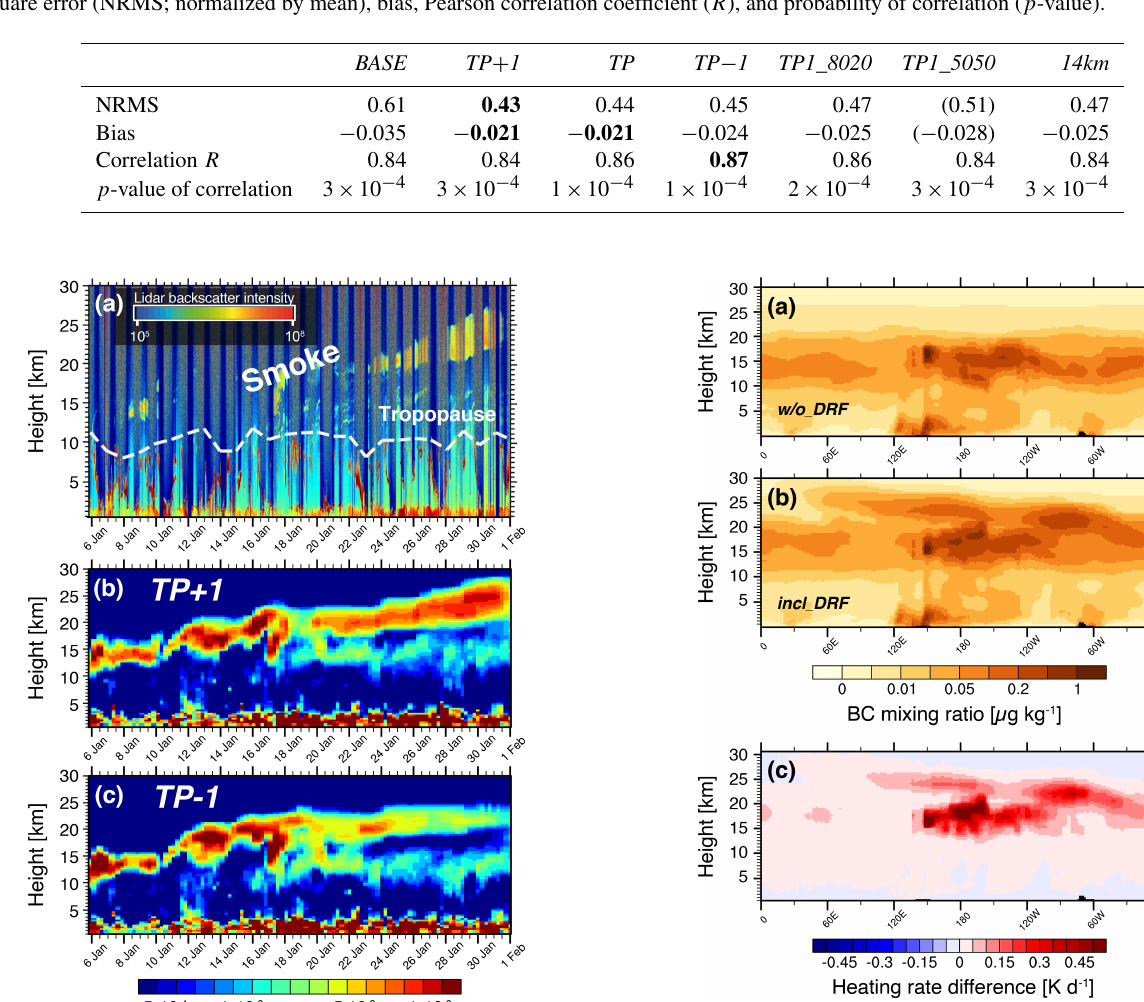
Table 2. Statistical key figures for the comparison of measured and simulated AOTs for the different model cases at the AERONET sun- photometer stations: Punta Arenas, Chile (53.14 ◦ S, 70.89 ◦ W), Amsterdam Island (37.80 ◦ S, 77.57 ◦ E), Marambio (64.24 ◦ S, 56.63 ◦ W), Vechernaya Hill (67.66 ◦ S, 46.16 ◦ E), and South Pole (90.00 ◦ S). The numbers in bold denote the cases with the best match for the respective statistical variables, the numbers in brackets denote the cases with least agreement (excluding case BASE ). From top: Normalized Root Mean Square error (NRMS; normalized by mean), bias, Pearson correlation coefficient ( R ), and probability of correlation ( p -value).